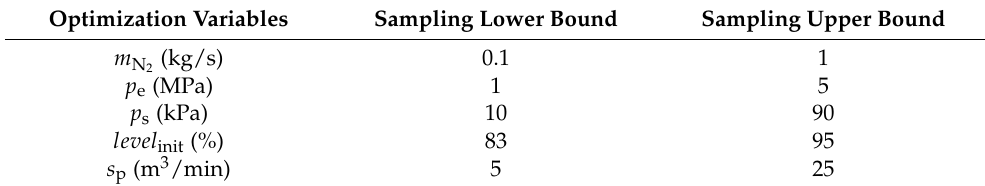
Table 2. Range of sampling